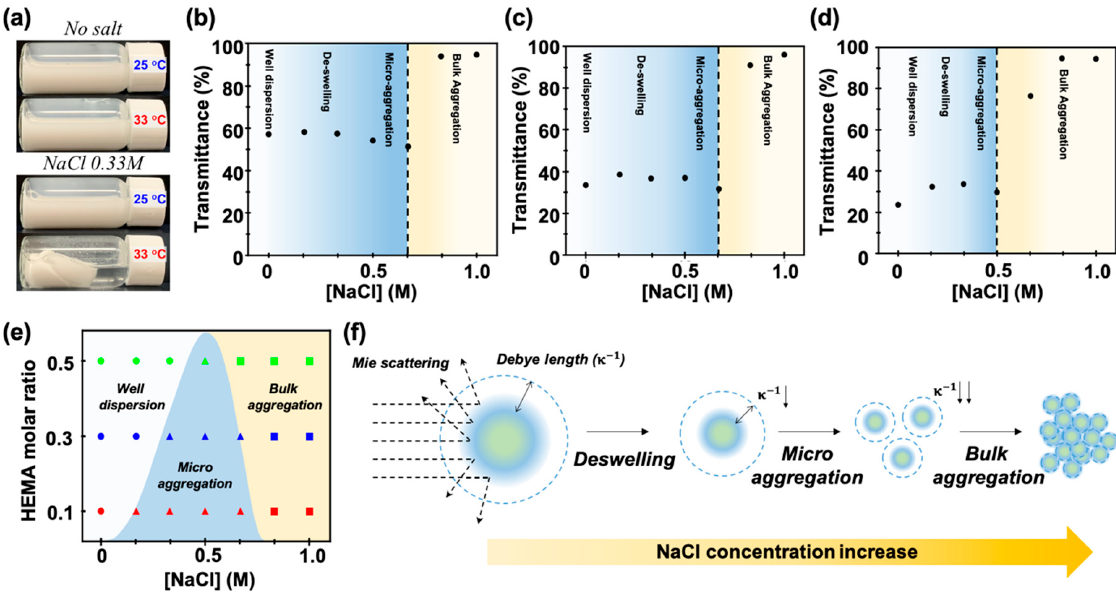
Figure 2. ( a ) Photograph images of thermogelling p(NiPAm-co-HEMA) microgel dispersion upon different temperature conditions. In the absence of salt, the dispersion remained at the sol state for both 25 °C and 33 °C (top panel). In the presence of 0.33 M of sodium chloride (NaCl), microgels dispersion showed volume phase transition from sol to gel state at 33 °C (bottom panel). ( b – d ) The transmittance of p(NiPAm-co-HEMA) microgel dispersion with molar ratios between NiPAm and HEMA of ( b ) 9:1, ( c ) 7:3, and ( d ) 5:5, respectively, with respect to NaCl concentration. The bulk aggregation of microgels by the strong ionic strength of solution was expressed in yellow background. ( e ) Summary of dispersion quality of p(NiPAm-co-HEMA) microgels. The microgel showed a well-dispersed (white background) phase, micro aggregation (blue background) phase, and bulk aggregation (yellow background) phase in accordance with NiPAm: HEMA molar ratios and NaCl concentrations. ( f ) Schematic illustration of deswelling of microgel with the increase of the salt concentration.